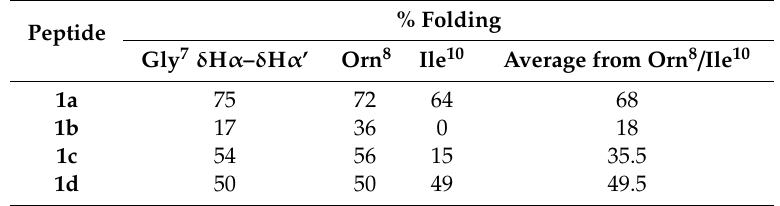
Table 2. % folding based on glycine 7 splitting and H α chemical shifts for Orn 8 and Ile 10